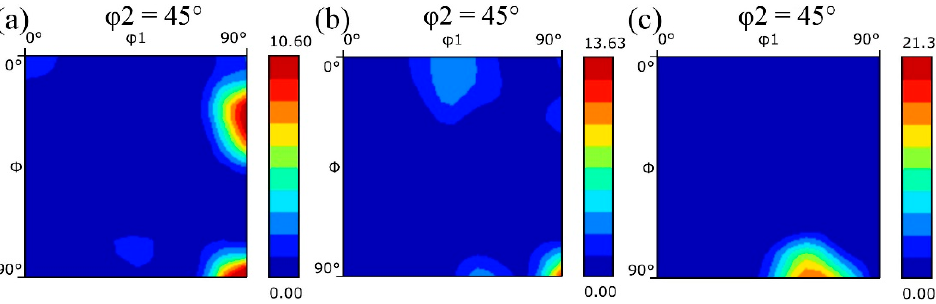
Figure 8. EBSD surface IPF orientation maps of samples rolled with different deformation temper-